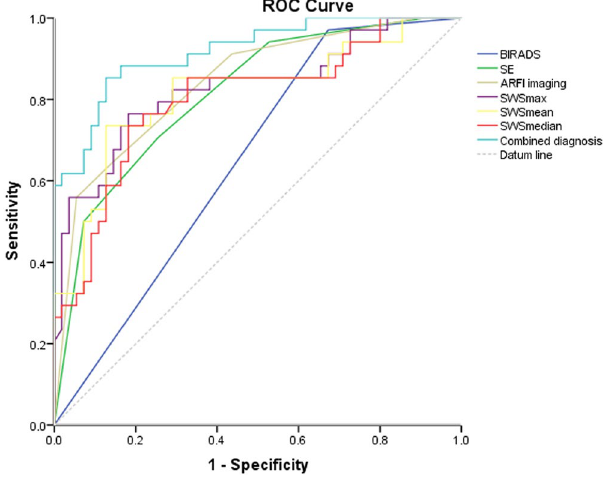
Figure 4. In ROC curve analyses, associated Azs of BI-RADS, SE, VTI, SWS max, SWS mean, SWS median and combined diagnostic method are 0.649, 0.814, 0.840, 0.829, 0.815, 0.801 and 0.918,